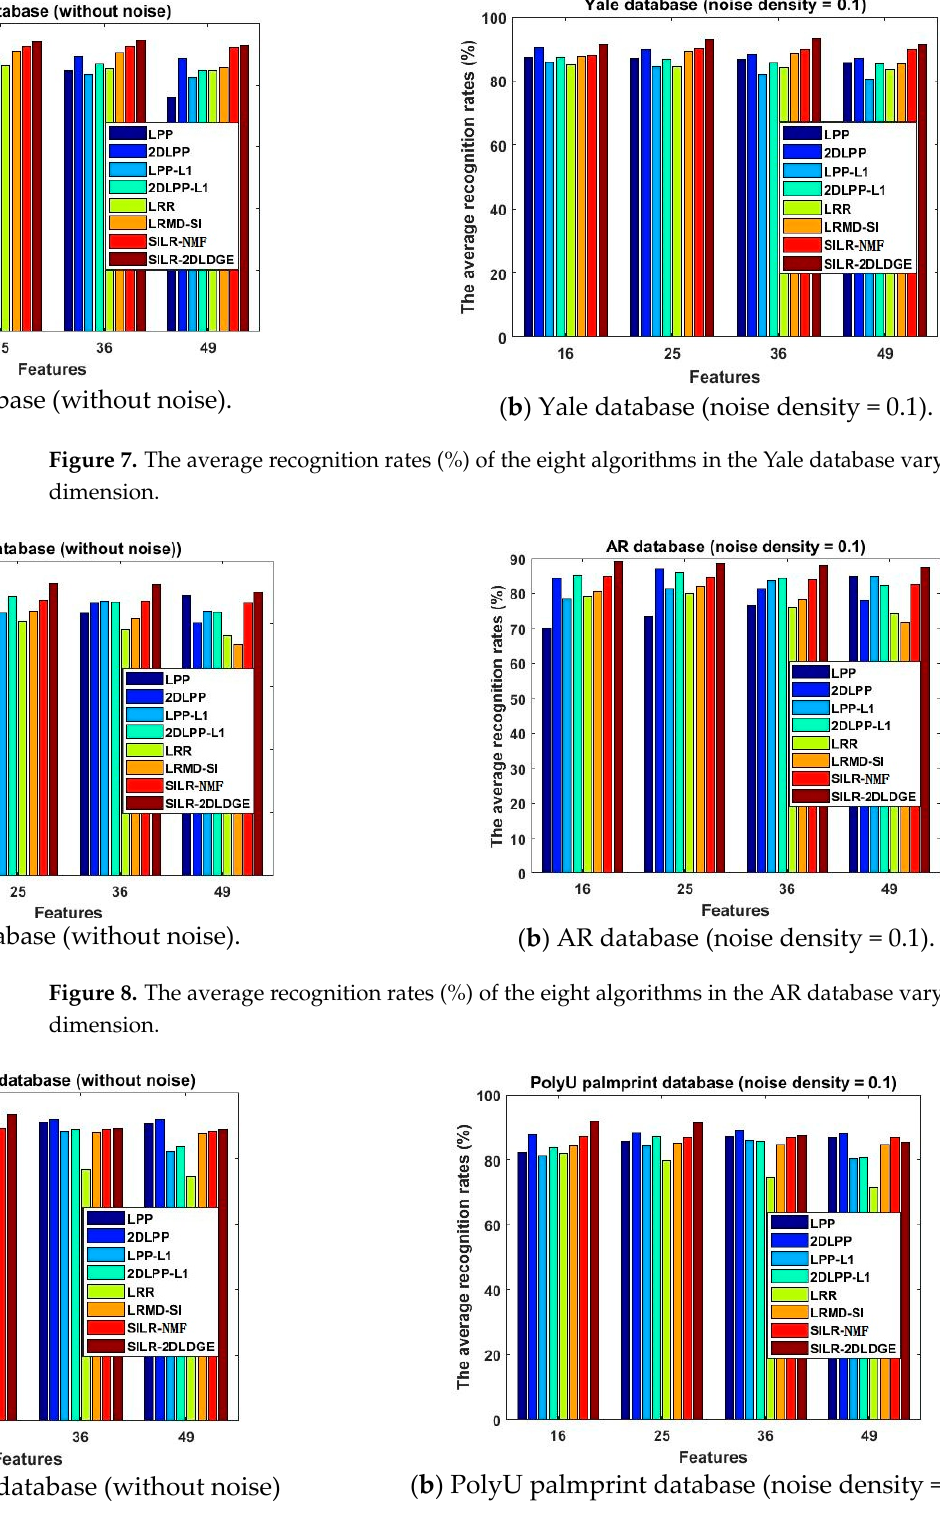
Table 3. The best average recognition rates (%) of different algorithms and corresponding dimen- sions (D) on the Yale, AR, and PolyU databases and the corresponding dimensions.